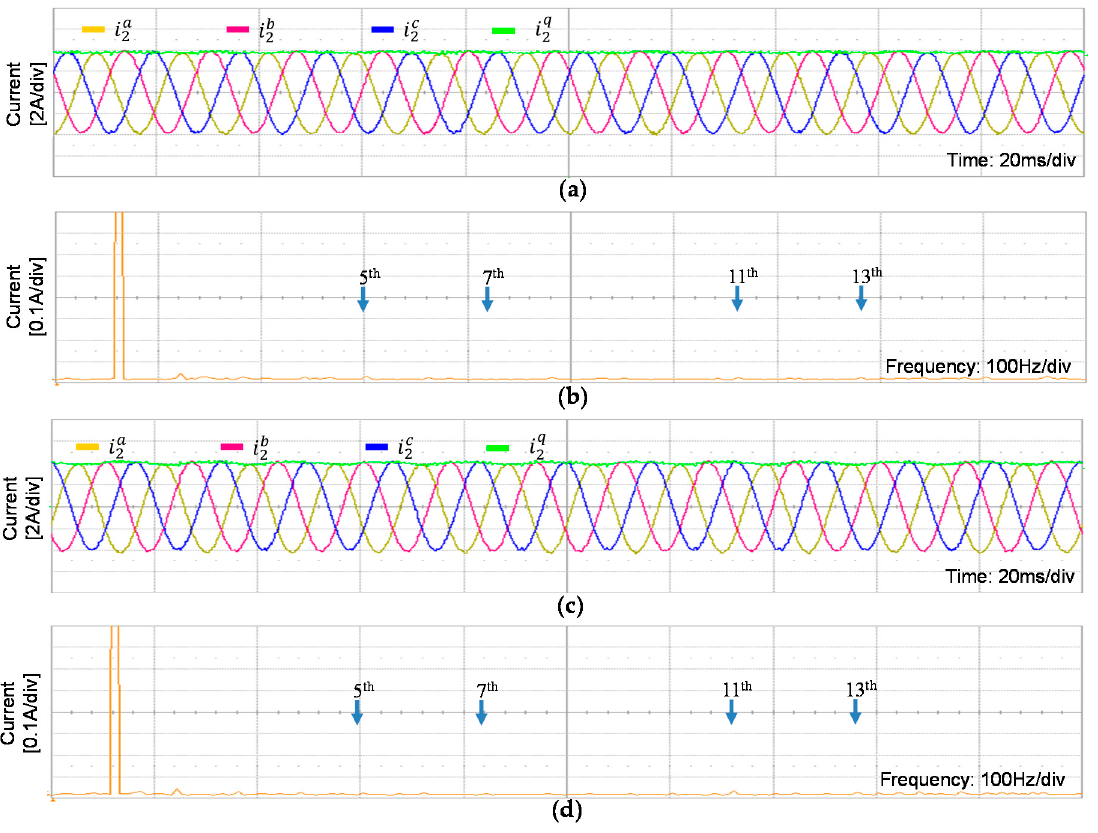
Figure 20. Experimental results of the proposed controller under the LCL filter parameter variations. ( a ) Three-phase grid currents: the filter capacitance C f decreases from 4.5 µ F to 3 µ F; ( b ) FFT result of phase- a current: the filter capacitance C f decreases from 4.5 µ F to 3 µ F; ( c ) three-phase grid currents: the filter capacitance C f increases from 4.5 µ F to 6 µ F; and ( d ) FFT result of phase- a current: the filter capacitance C f increases from 4.5 µ F to 6 µ